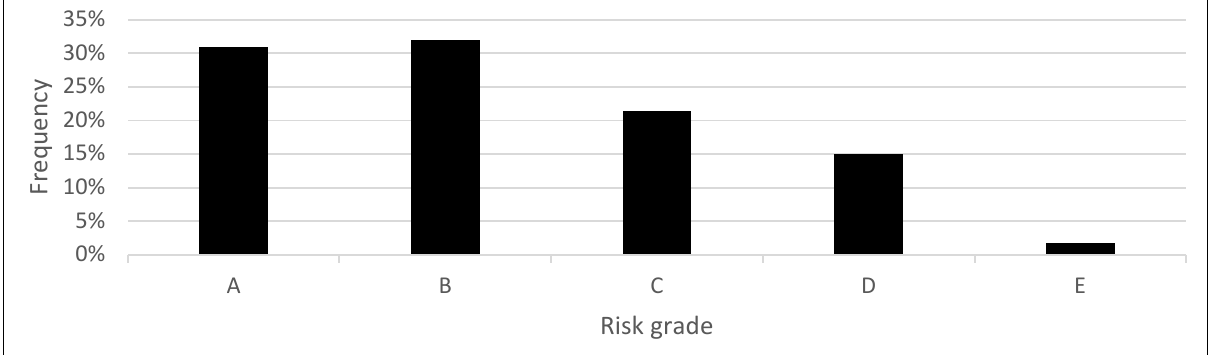
Figure 1: Risk grades of the home loans analysed (with Risk Grade A being the lowest risk and Risk Grade E the highest risk).